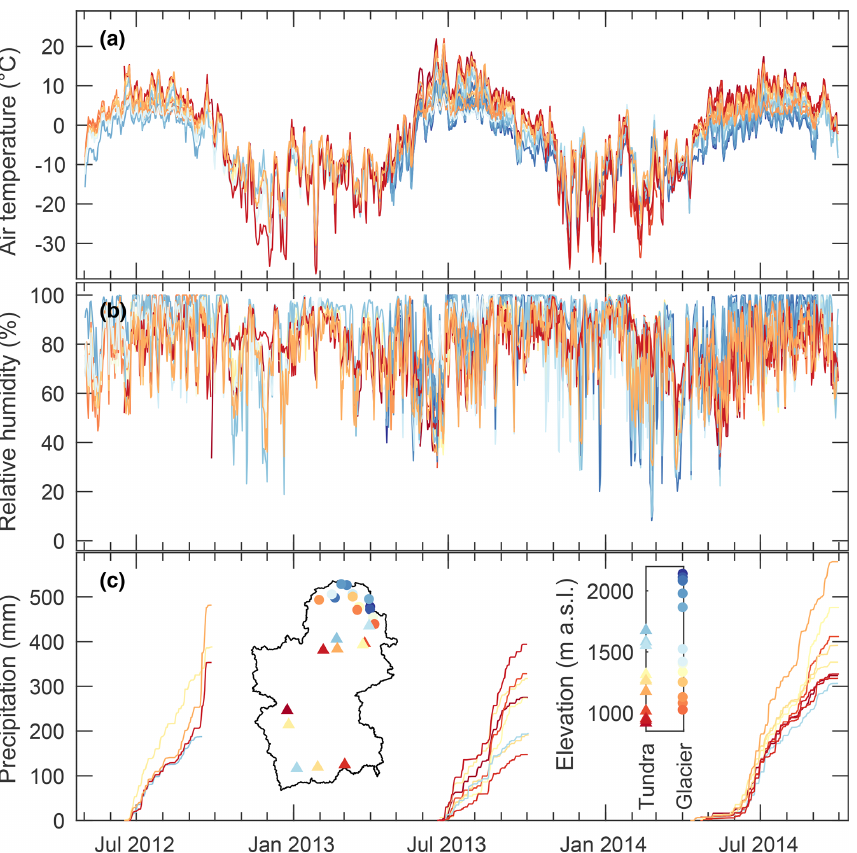
Figure 9. Daily mean temperature (a) , relative humidity (b) , and cumulative precipitation (c) for the tundra and glacier stations. Data are colored by station elevation (inset graph). The inset map shows station